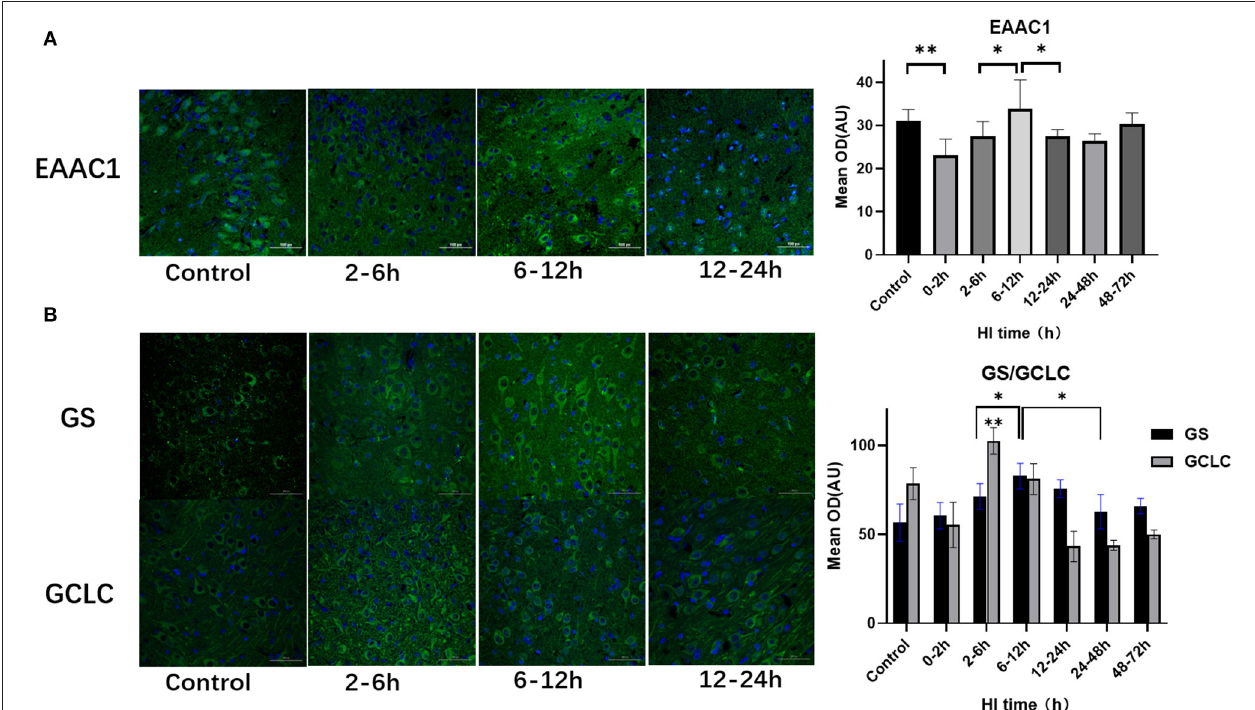
FIGURE 3 | Differences in the expression of EAAC1, GS, and GCLC after HI injury ( × 400). (A) Tendency chart for cerebral EAAC1 staining and mean integrated optical density in the control group and the experimental groups at 2–6 h, 6–12 h, and 12–24 h after HI injury. Green fluorescence represents EAAC1. Compared with the control group, the fluorescence intensity in the experimental group decreases at 0–2 h, increases at 6-12 h, and then decreases again at 12–24 h after HI injury. (B) Tendency chart for cerebral GCLC and GS staining and mean integrated optical density in the control group and the experimental groups at 2–6h, 6–12 h, and 12–24 h after HI injury. Green fluorescence represents GCLC and GS. The fluorescence intensity of GCLC and GS reach their peaks at 2–6 h and 6–12 h after HI injury, respectively. ** P < 0.01, * P < 0.05, and data are expressed as mean ± standard